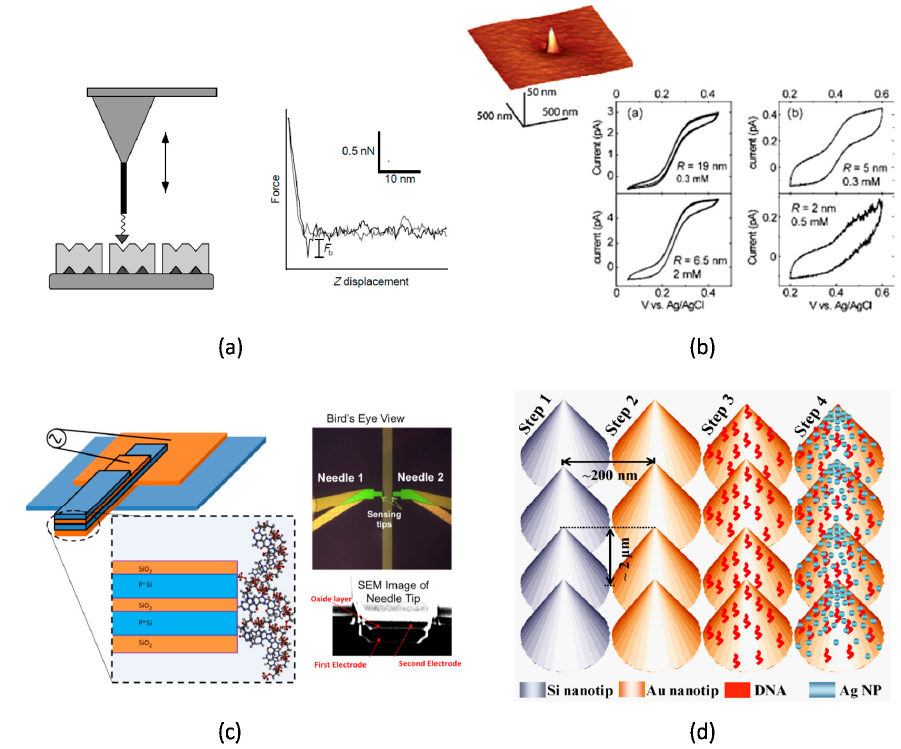
Figure 2. ( a ) (Left) Diagram illustrating a nanotube tip covalently modified with a biotin ligand (dark-grey triangle) interacting with streptavidin protein receptors (light-grey blocks). (Right) Representative force–displacement curve recorded with a biotin-modified nanotube tip on the streptavidin surface in pH 7.0 PBS. The inset represents the scale bar. The binding force is indicated by F b . Reproduced with permission from reference [31]. Copyright 1998 Nature; ( b ) (Left) AFM topography image of a nanoelectrode. (right) Cyclic voltammograms obtained for different electrodes recorded in solutions of Fc(CH 2 OH) 2 and FcTMA. Reproduced with permission from reference [25]. Copyright 2006 American Chemical Society; ( c ) (Left) Schematic of nanoneedle biosensor three-dimensional and side view of horizontal nanoneedles (Not drawn to Scale). (Top right) Optical micrograph of bird’s eye view of aluminum-polysilicon hybrid nanoneedle biosensor. (Bottom right) SEM image of the tip of a nanoneedle biosensor. Reproduced with permission from reference [26]. Copyright 2013 American Institute of Physics; ( d ) A schematic of the pathway for generating the SERS platform for efficient Raman signal enhancement. Reproduced with permission from reference